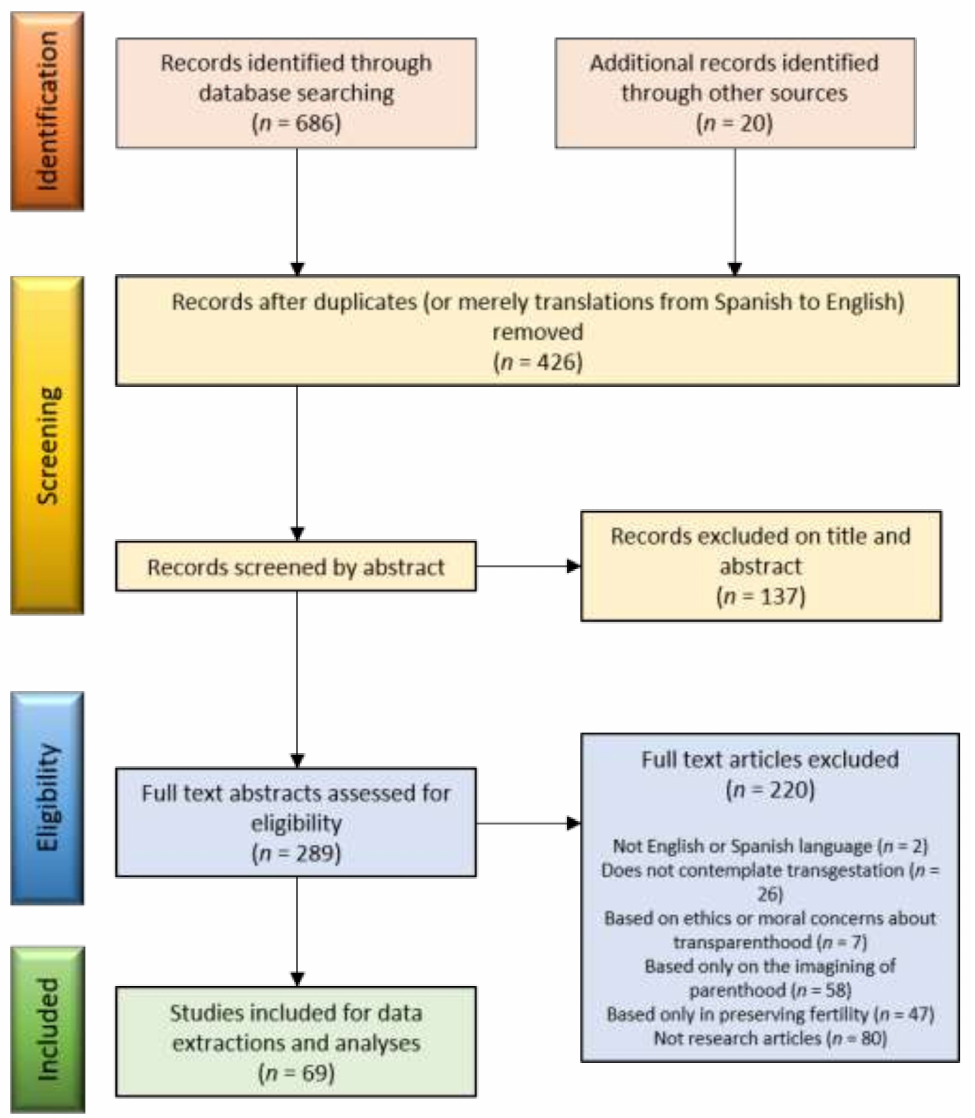
Figure 1. A flowchart showing phases of the literature search for extraction of the most specific literature for the